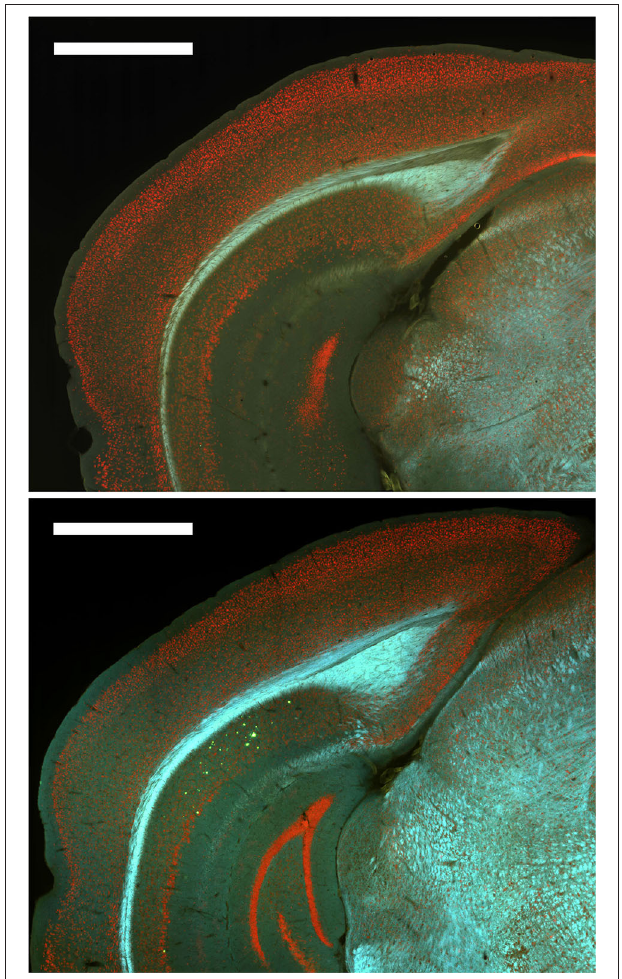
FIGURE 8 | Plaques were absent from most brain regions for all groups except 12-month male 3xTg-AD mice. Top . Representative image of Thioflavin S staining for a 6-month female 3xTg-AD mouse with no plaques. Bottom. Representative image of Thioflavin S staining for a 12-month male 3xTg-AD mouse with plaques (green) in dorsal subiculum